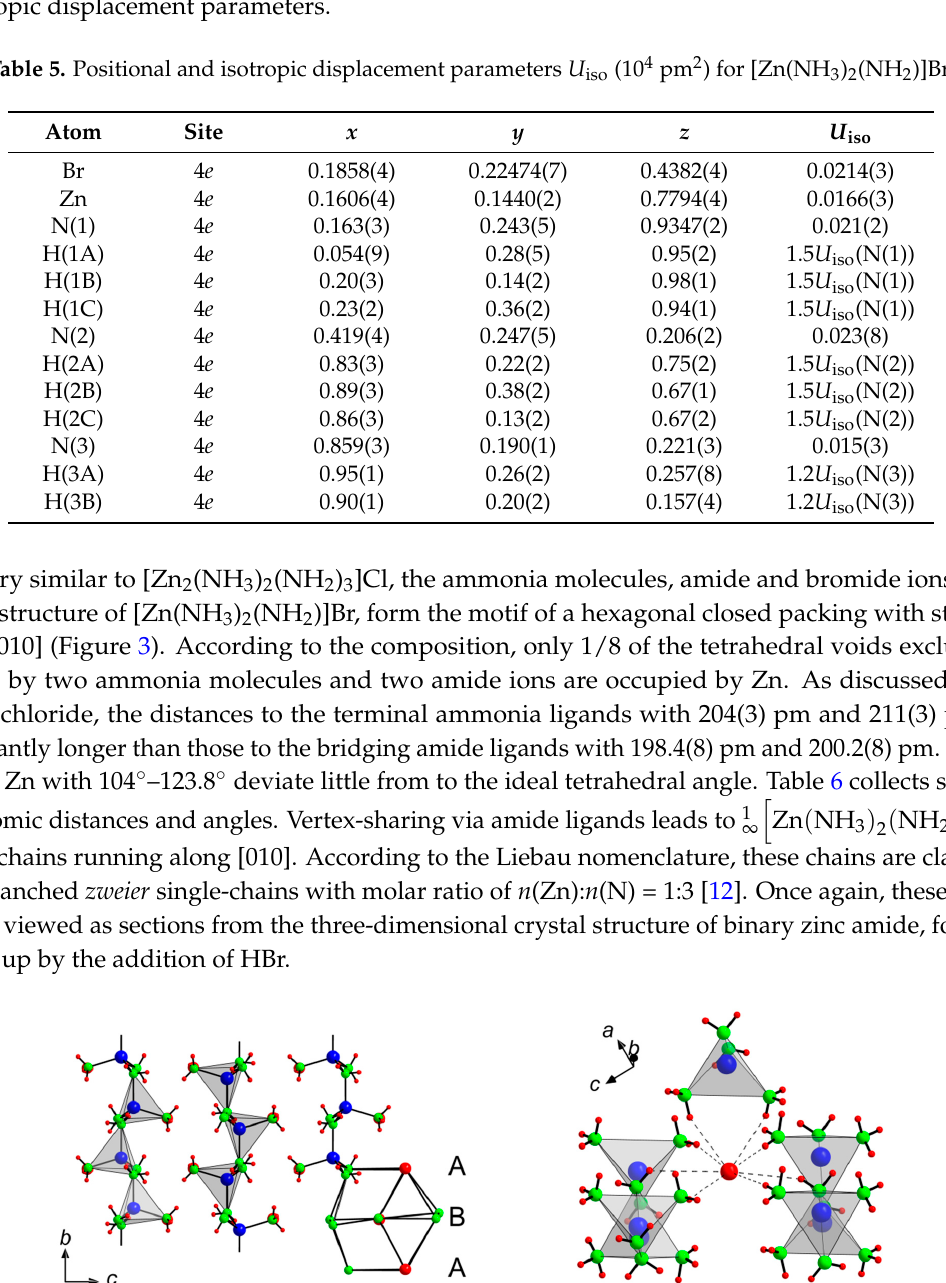
Figure 3. Sections of the crystal structure of [Zn(NH 3 ) 2 (NH 2 )]Br: ( a ) infinite 1 ∞ 2/221 ( ) ( ) + Zn NH NH zigzag chains result from occupation of tetrahedral voids exclusively built by amide ions and ammonia molecules by Zn within the motif of an hcp formed by bromide and amide ions together with ammonia molecules (the hcp stacking motif is indicated by an anticuboctahedron and capital letters); ( b ) every bromide ion employs eight H-bonds and interconnects three chains (large red spheres: Cl, green spheres: N, small red spheres: H, and blue spheres surrounded by grey tetrahedra: Zn). Table 6. Selected interatomic distances (pm) and angles (deg.) in the crystal structure of [Zn(NH 3 ) 2 (NH 2 )]Br.